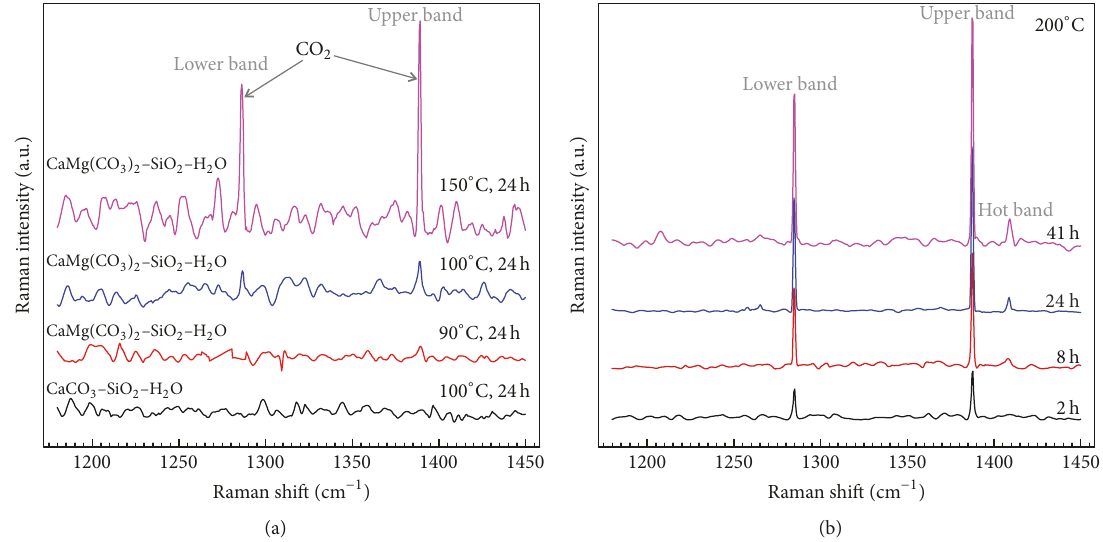
Figure 3: Raman spectra of the vapor phase in FSCCs containing (a) CaCO 3 –H 2 O and CaMg(CO 3 ) 2 –H 2 O after heating at 90–150 ∘ C for 24 h and (b) CaMg(CO 3 ) 2 –H 2 O after heating at 200 ∘ C from 2 to